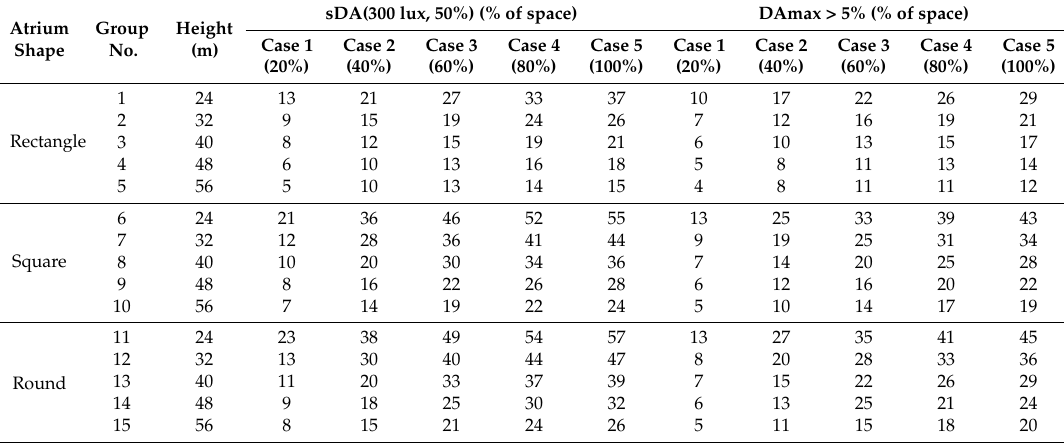
Table 2. Simulation